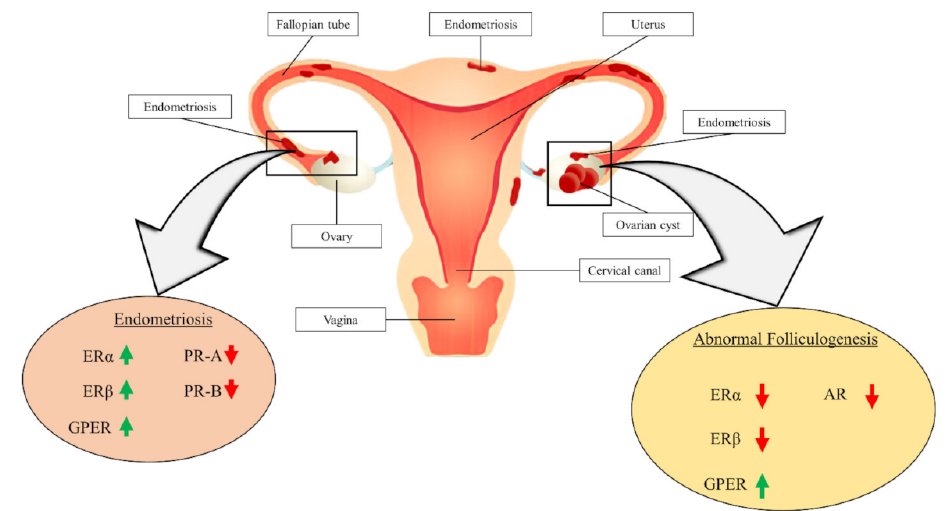
Figure 2. Association of receptor expression changes with the pathogenesis of abnormal folliculogen- esis and endometriosis. ER: oestrogen receptor; PR: progesterone receptor; AR: androgen receptor; GPER: G-protein oestrogen